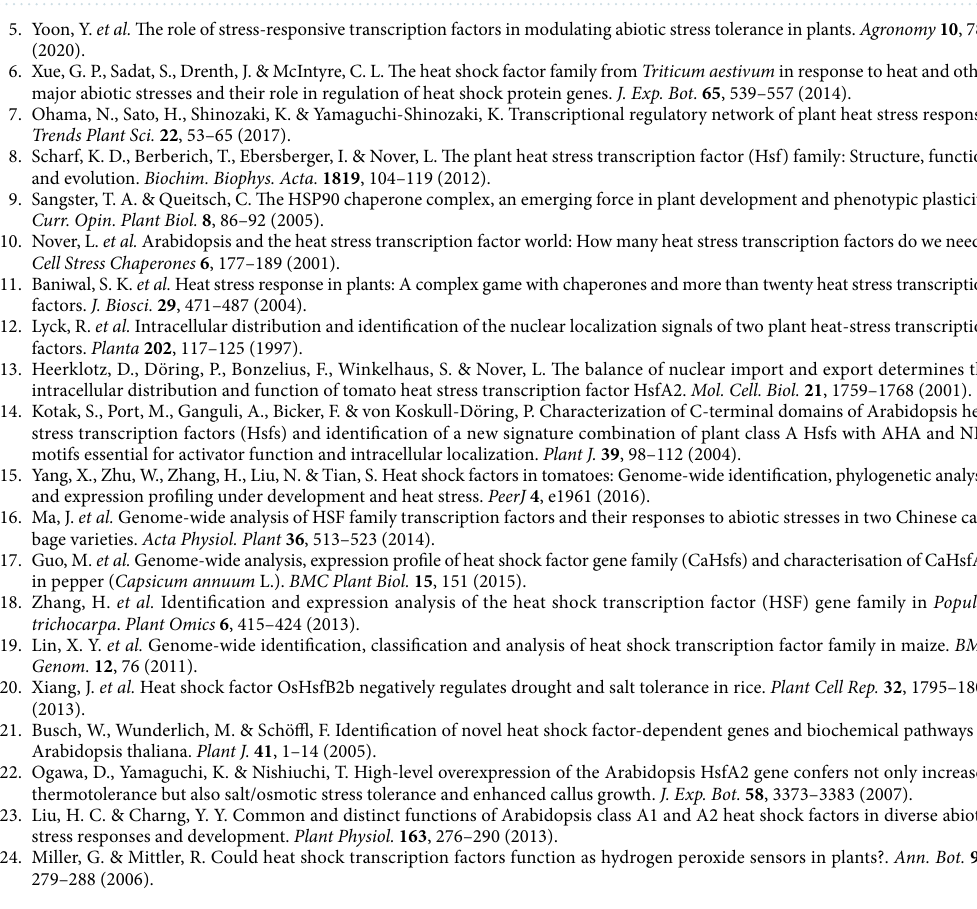
Figure 13. Predicted three-dimensional structures of the moso bamboo HSF protein sequences. ( a ) PeHsf15 was selected to represent the structure of the HsfA subfamily. ( b ) PeHsf28 was selected to represent the structure of the HsfB subfamily. ( c ) PeHsf26 was selected to represent the structure of the HsfC subfamily. Models were constructed using SWISS-MODEL. ARG, arginine. GOL, substrate. Predicted model structures were visualized and manipulated with Discovery Studio, version 2016 (BIOVIA) (http:// www. disco verys tudio.